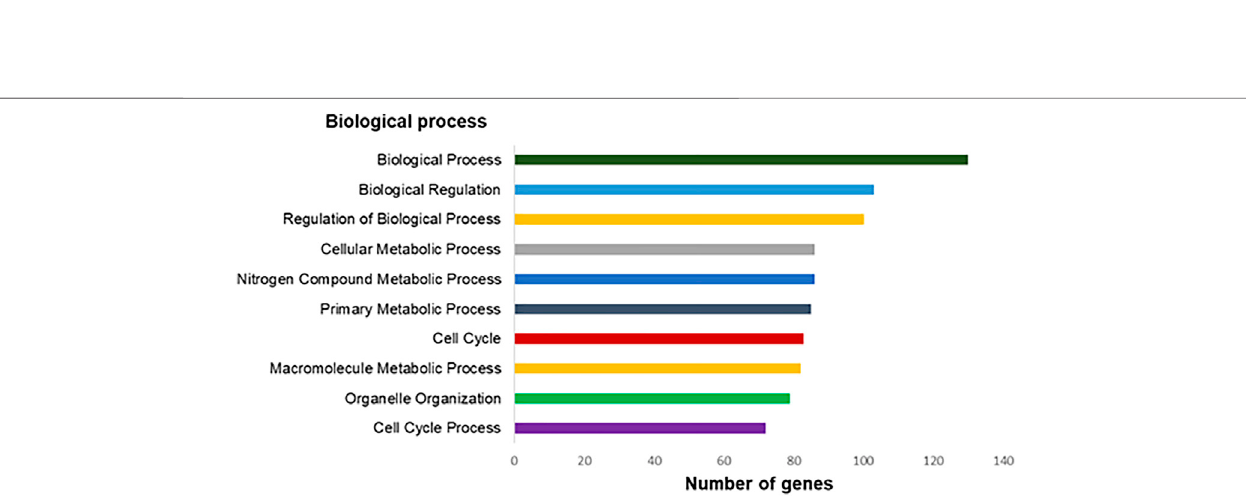
Frontiers in Pharmacology |